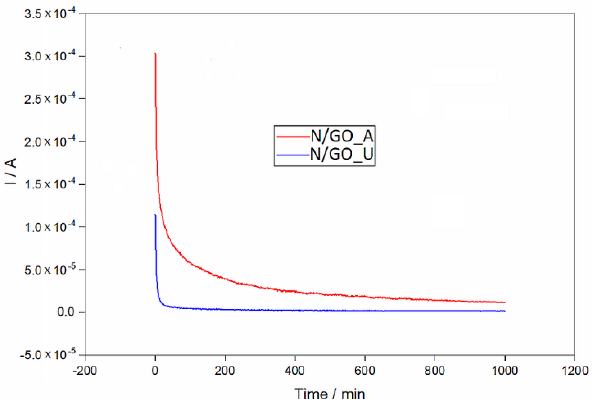
M KOH electrolyte at a constant potential of 0.3 V for 1000 min.